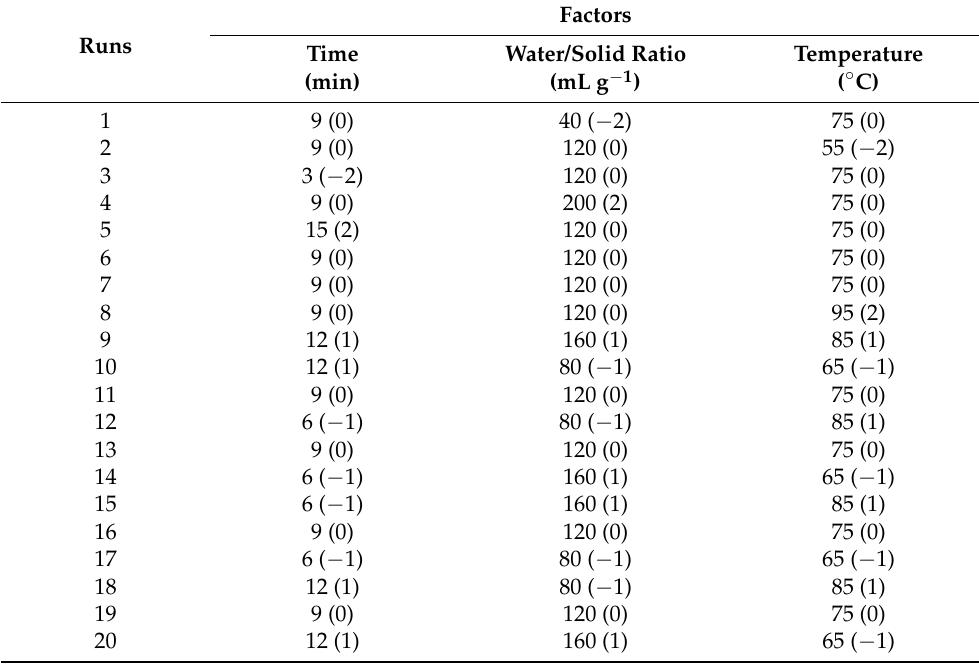
Table 1. Central Composite Design with actual and values for brewing factors. The coded values of variables are given in